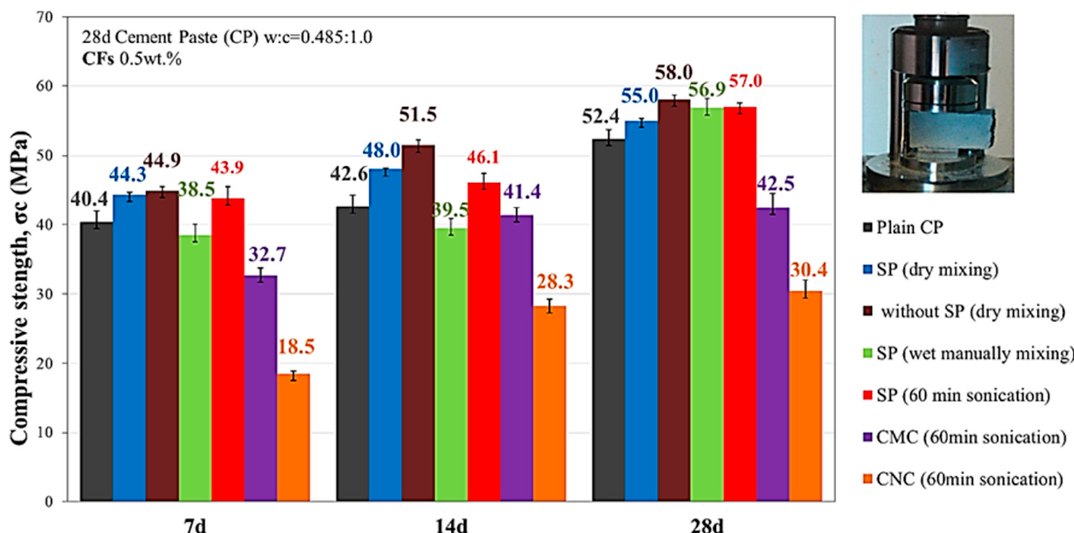
Figure 5. Compressive strength of plain cement pastes and CFs reinforced cementitious composites.